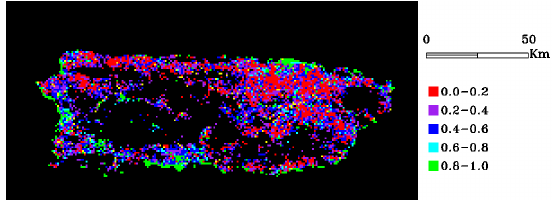
Figure 3. The percent of normal NTL power outage spatial extent. The NTL on September 30 is used for post-hurricane.